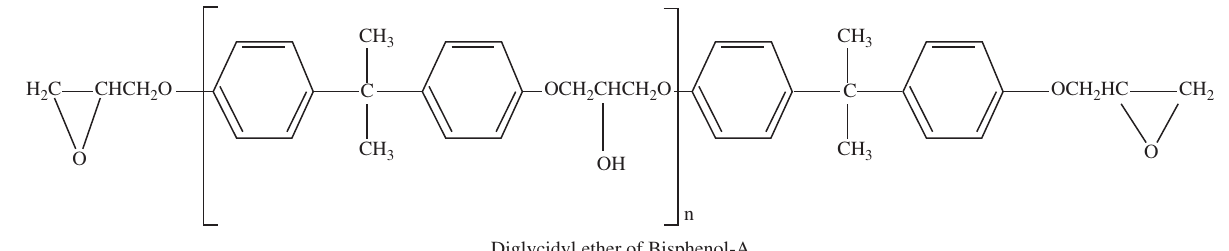
Figure 3. Chemical structure of DGEBA epoxy resin.